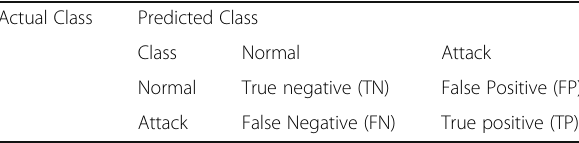
Table 6 Confusion Matrix for IDS